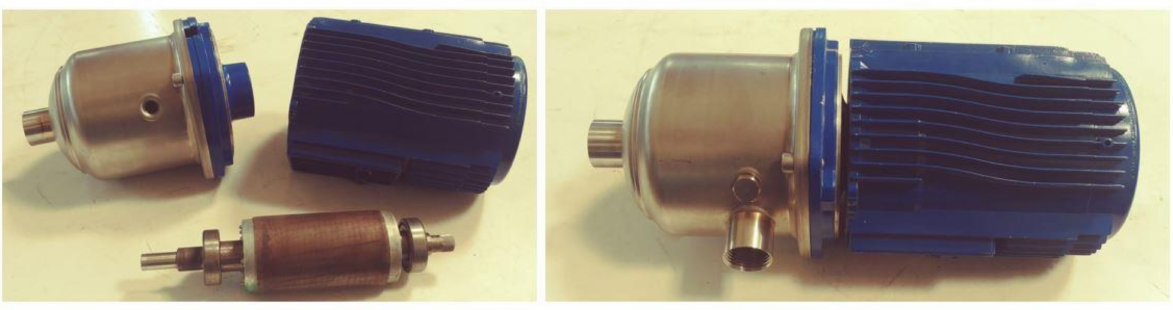
Figure 6. Reference product used for the lab experimental